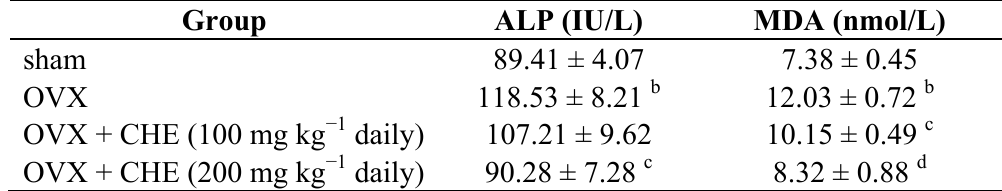
Table 4. Effect of Cistanches Herba extract treatment on blood alkaline phosphatase (ALP) activity and blood malondialchehyche (MDA) level.